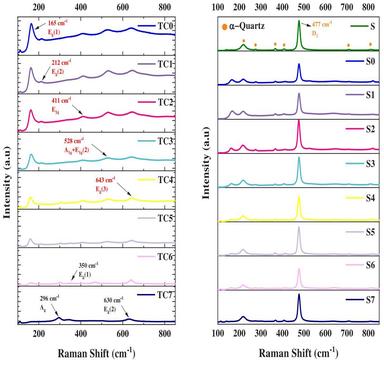
3D structure: (a) anatase (tetragonal); (b) tenorite (monoclinic); (c) α-quartz (trigonal); (d) Cuprite (cubic). Source: Drawn in VESTA 3 using AMC data from American Mineralogist Crystal Structure Database-Rruff ((http://rruff.geo.arizona.edu/AMS/amcsd.php) (http://rruff.geo.arizona.edu/AMS/amcsd.php))